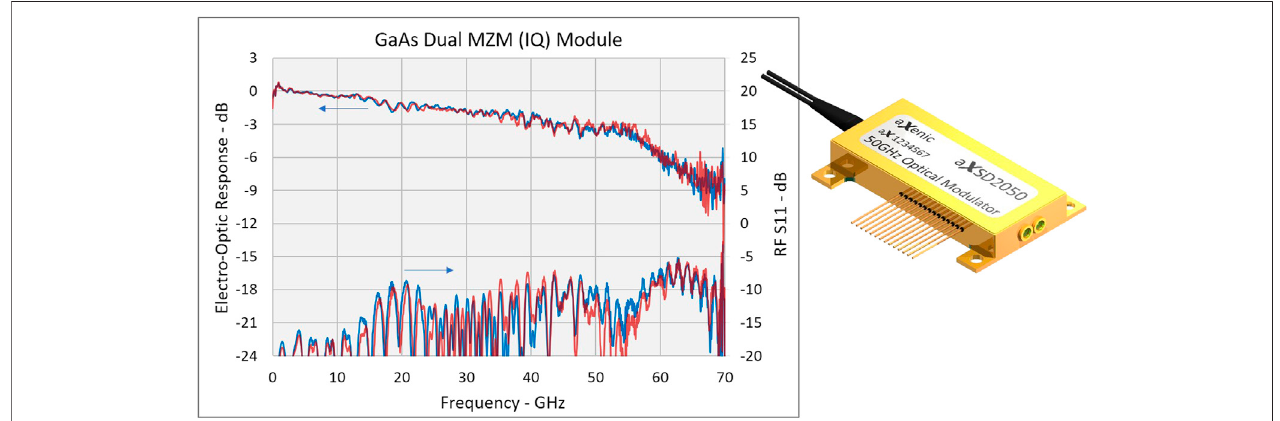
FIGURE4| Measuredelectro-opticRFcharacteristicsforbothIandQchannelsofa50 GHzfolded-pathGaAsIQmodulatormodule.Eachchannelissimilartothe 18 mm folded device of Figure 2 .